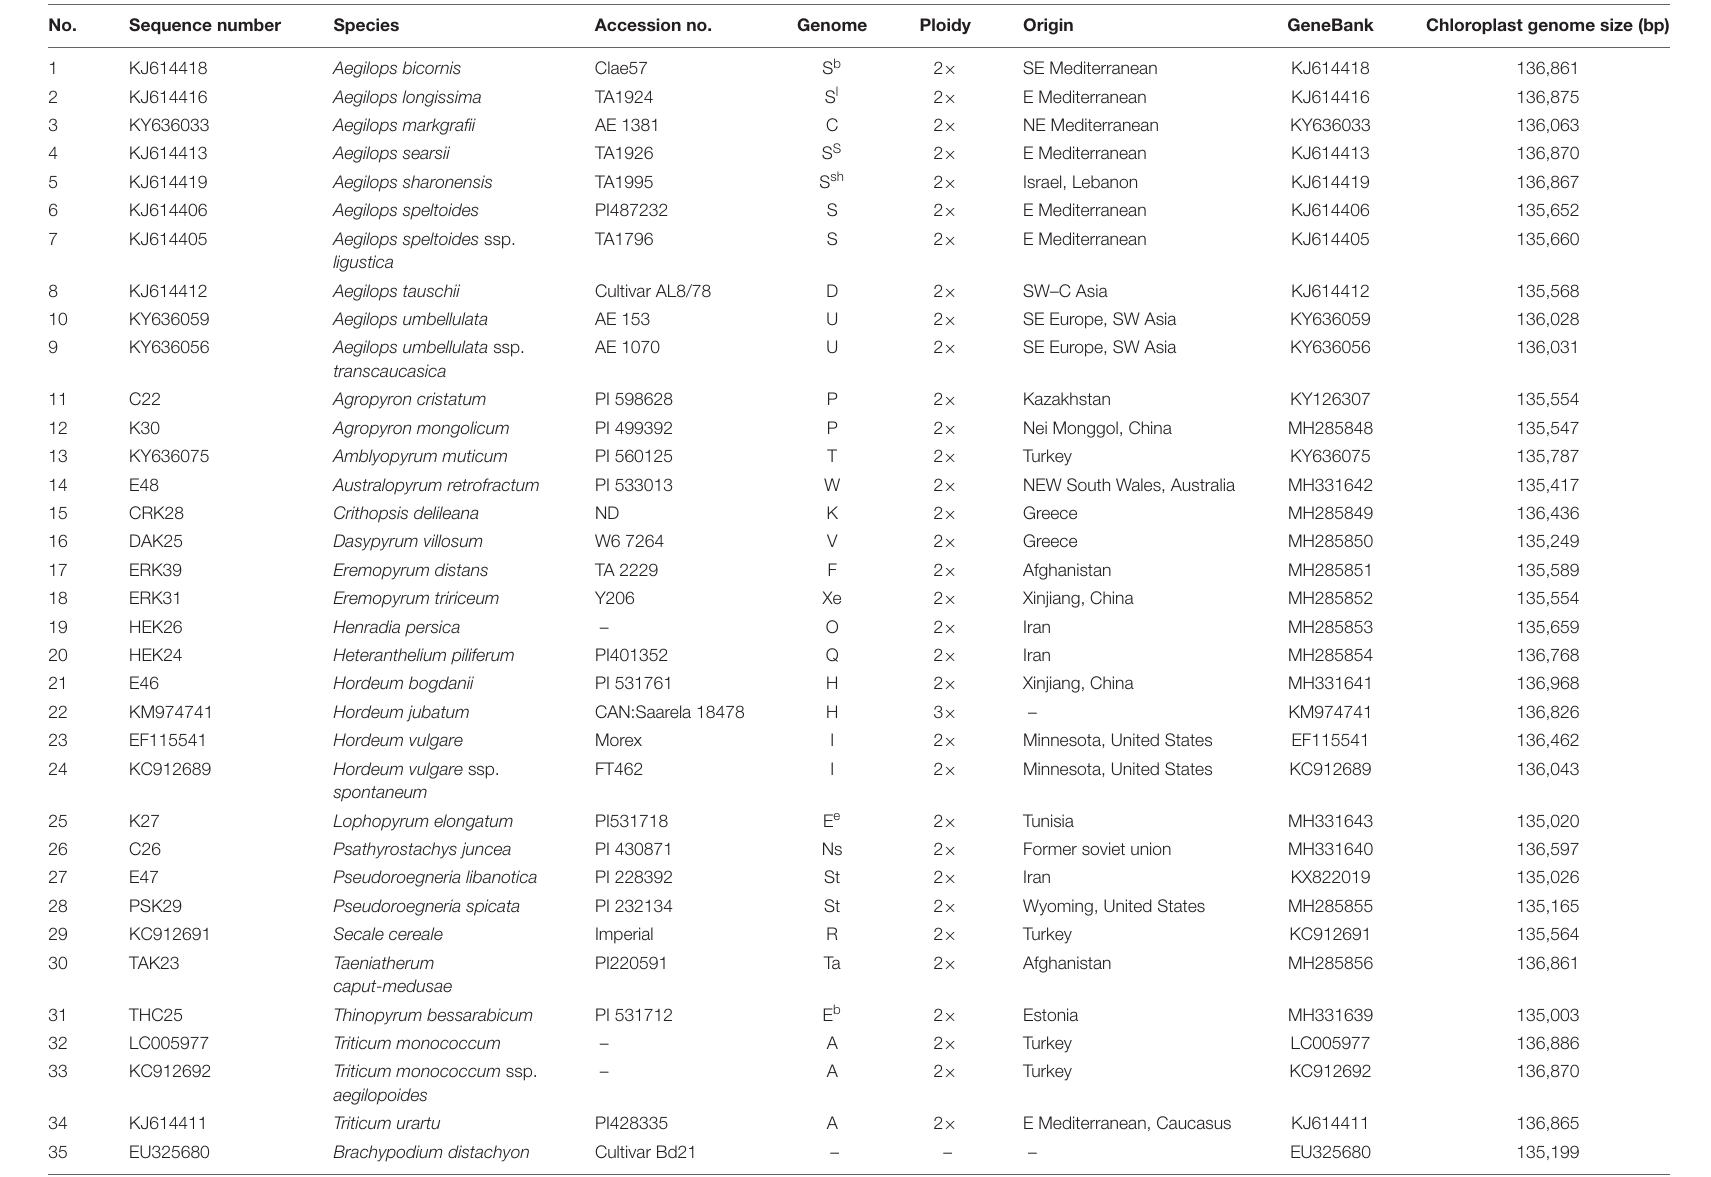
TABLE 1 | List of taxa used in this